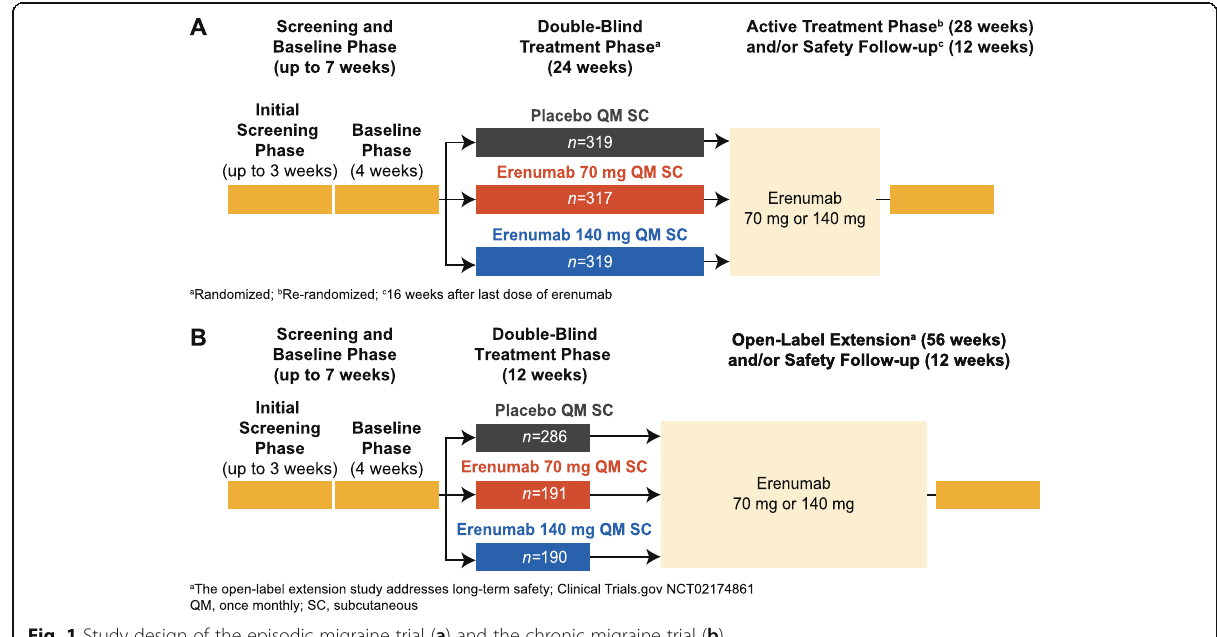
Fig. 1 Study design of the episodic migraine trial ( a ) and the chronic migraine trial ( b